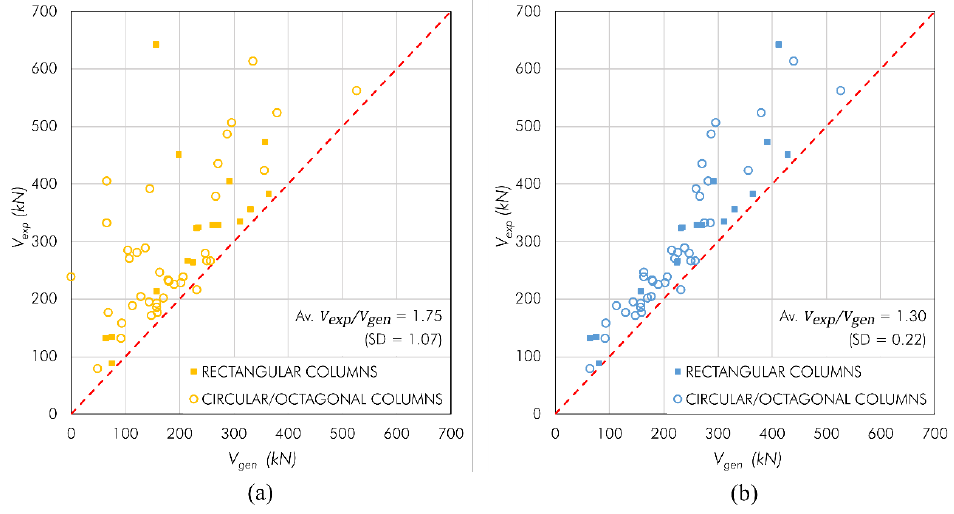
Figure 4. Shear strength predictions of rectangular, circular, and octagonal columns using the AASHTO General Procedure: ( a ) With reduction in 𝑉 𝑐 for low axial load levels; ( b ) Without reduction in 𝑉 𝑐 .